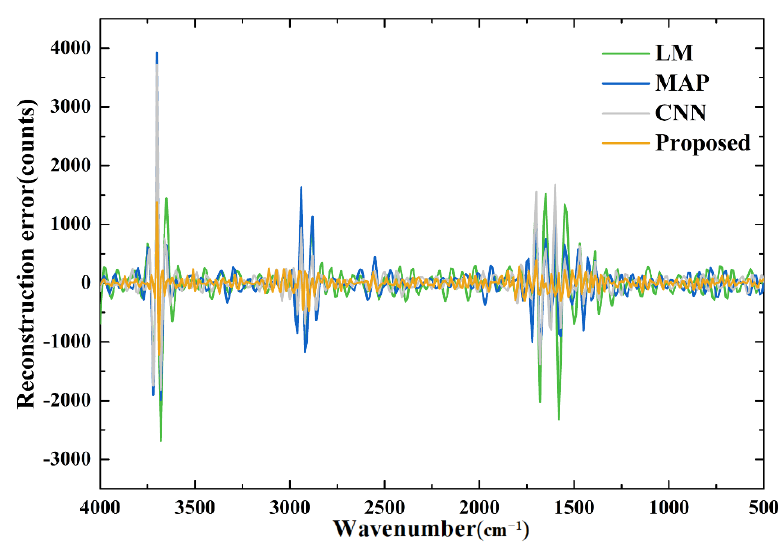
Figure 3. Reconstruction results of the Raman spectrum by several methods. ( a ) the LM method; ( b ) the MAP method; ( c ) the CNN method; ( d ) the proposed method.